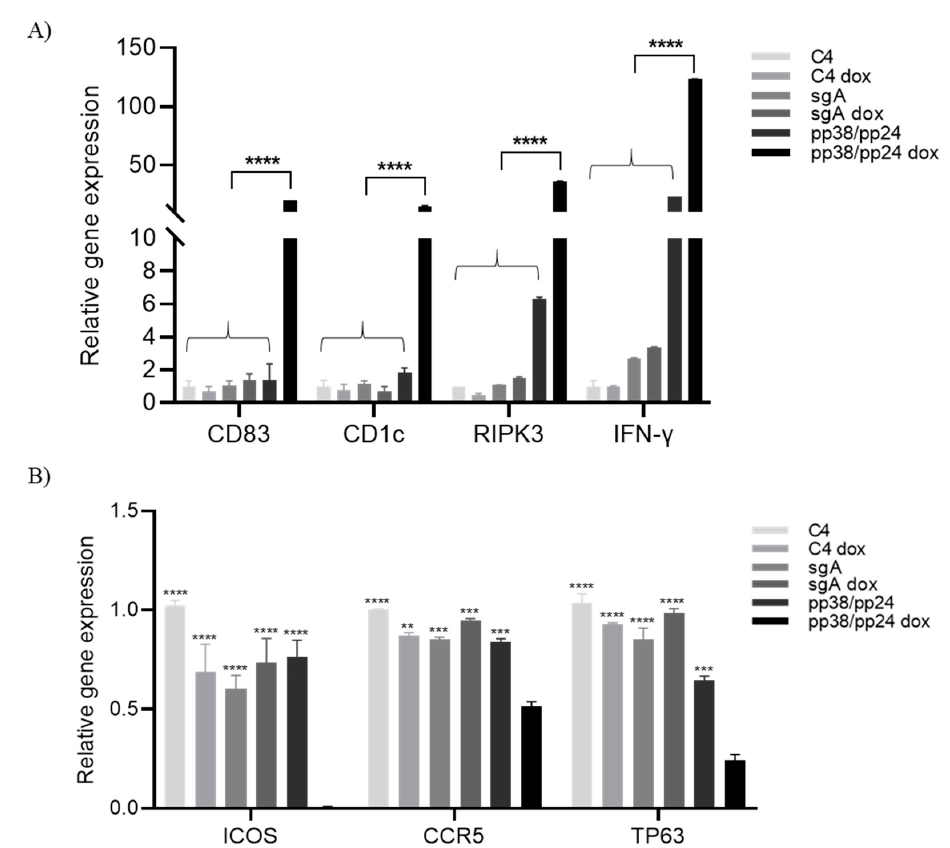
Figure 3. Differential expression of host genes in pp38/pp24-overexpressed C4 cells. RT-qPCR analysis of differential expression of host genes in pp38/pp24-overexpressed population and the control cells. C4 cells were transfected with sgA or pp38/pp24-specific gRNAs in presence (C4 dox, sgA dox and pp38/pp24 dox) or absence of doxycycline (C4, sgA and pp38/pp24). RNA was extracted 24 h pt, followed by RT-qPCR analysis using gene-specific primers. The histogram represents the relative gene expression of host genes in C4 cells. Expression was normalized to the endogenous GAPDH. The relative fold change was compared with C4 cells and expressed as fold change (2 −ΔΔ CT ). ( A ) Histogram representing up-